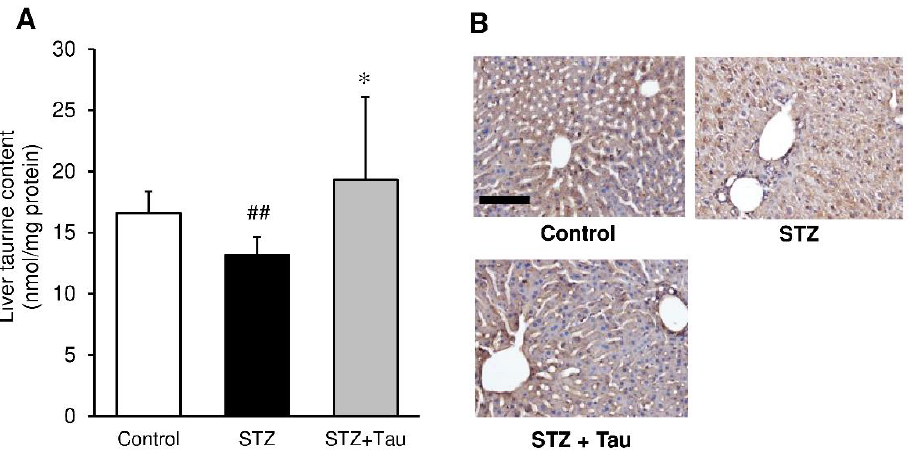
Figure 8. Effects of taurine supplementation on liver taurine content in diabetic mice. Taurine was extracted from the liver and then determined using HPLC ( A ). The liver tissue was fixed with formalin and stained with an anti-taurine antibody ( B ). Each value is expressed as the mean ± S.D. ( n = 7–8), ## p < 0.01 vs Control group, * p < 0.05 vs STZ group. Scale bar = 100 μm .